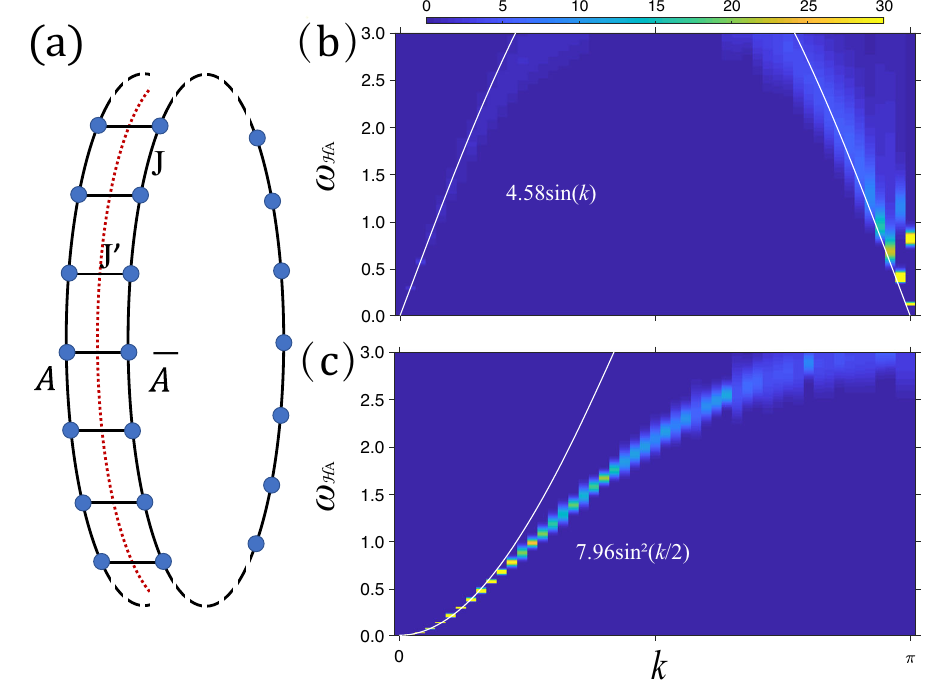
Fig.2|ESofHeisenbergladder.a Heisenbergspinladder.Thereddashedlinecut it into two entangled constituents, A and A . b The low-lying ES with L =100, J 0 =1 : 732, J =1 and β =100, β A =200. The white line is fi tting to the data with the